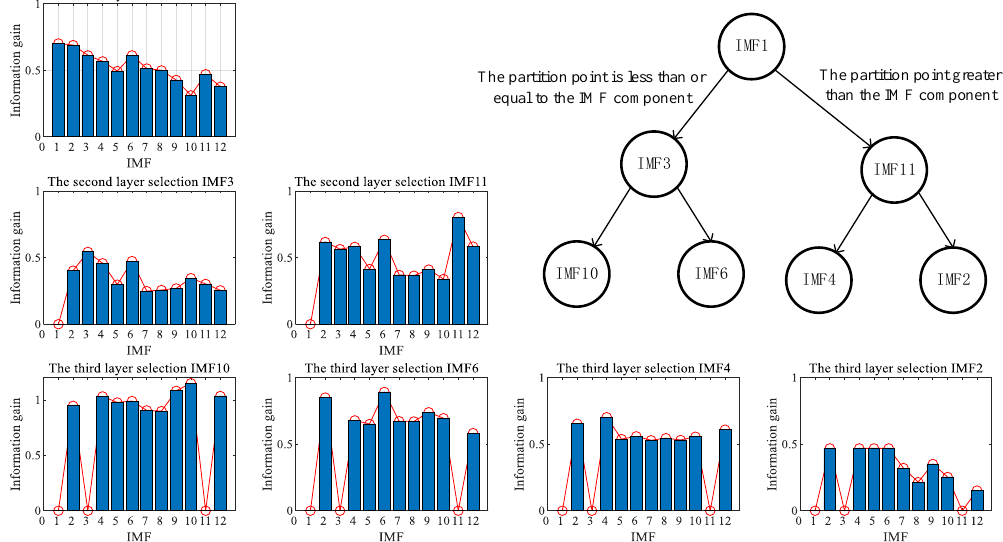
Figure 6. Component diagrams from information gain filtering.